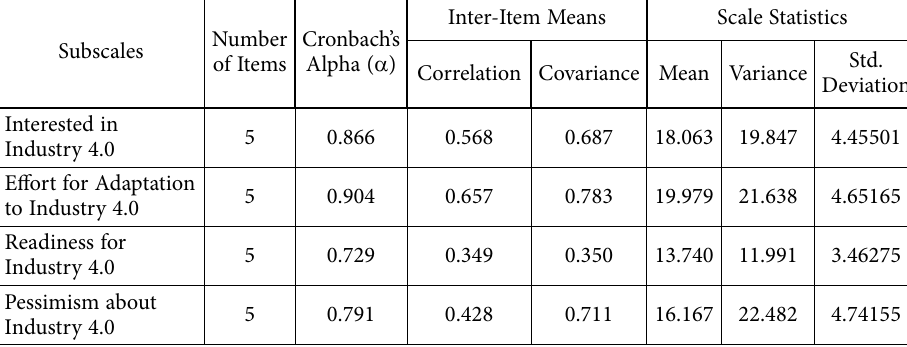
Table 1. Reliability analyses results of the pilot study